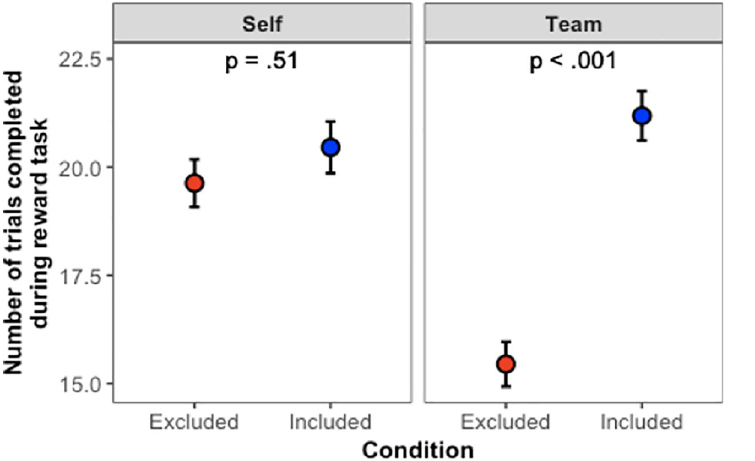
Fig 4. Main results from Study 2. Error bars show ± 1